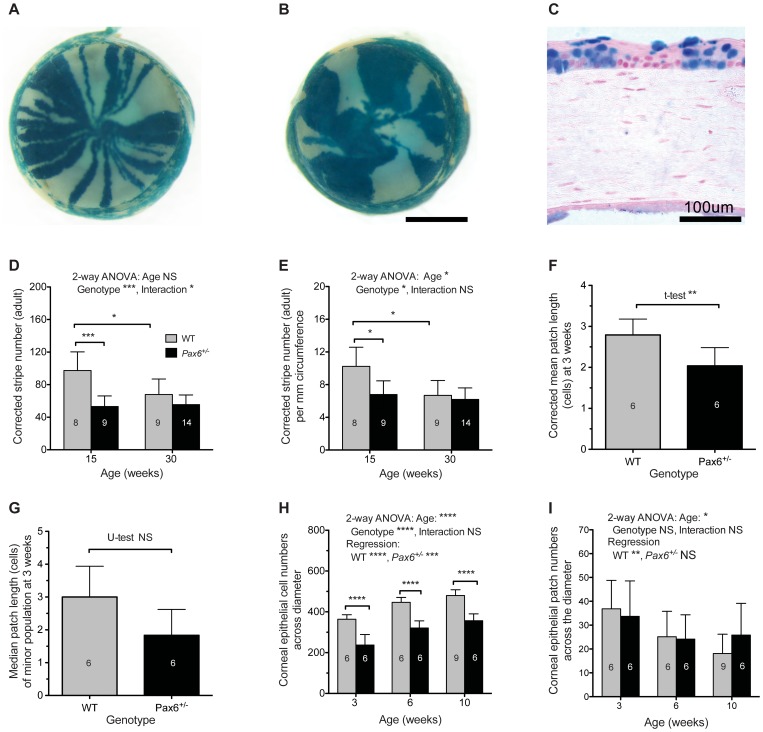
Analysis of mosaic patterns in the corneal epithelium of adult and 3–10 week old WT and Pax6+/− X-inactivation mosaics.(A) Adult WT XLacZ+/− mosaic eye showing characteristic radial stripes in the corneal epithelium. (B) Adult Pax6+/− XLacZ+/− mosaic eye showing disrupted patterns with larger, more irregular patches. (C) Section through cornea of a 3-week old XLacZ+/− mosaic mouse eye showing β-gal positive and β-gal negative patches that were measured in the basal corneal epithelium. (D, E) Corrected stripe numbers per circumference (D) and corrected stripe numbers per mm of corneal circumference (E) for corneal epithelia from adult WT and Pax6+/−, X-inactivation mosaics at 15 and 30 weeks. Statistical comparisons were made by 2-way analysis of variance (ANOVA) followed by pairwise Bonferroni post-hoc tests. (F, G) Corrected mean patch lengths (in cell numbers across the corneal diameter of the basal corneal epithelium) for the β-gal positive cell population (F) and median patch lengths for the minor cell population (G) in WT and Pax6+/− mosaics at 3 weeks. Statistical comparisons were made by Student’s t-test with Welch’s correction (F) and Mann-Whitney U-test (G). (H, I) Mean numbers of cells (H) and patches (I) across the corneal diameter of the basal corneal epithelium in WT and Pax6+/− mosaics at three ages. Statistical comparisons were made by 2-way ANOVA followed by pairwise Bonferroni post-hoc comparisons of genotypes and separate linear regression analyses of ages for WT and Pax6+/− genotypes. Abbreviations: WT, wild-type; NS, not significant; *P<0.05; **P<0.01; ***P<0.001; ****P<0.0001. In D and E, corrected stripe numbers were calculated for both eyes and the mean value for each mouse was used for analysis. In F-I, the central histological section of one eye per mouse was analysed. The numbers of eyes per group is shown within the bars. Error bars are 95% CI. Scale bars: A,B = 1 mm; C = 100 µm.